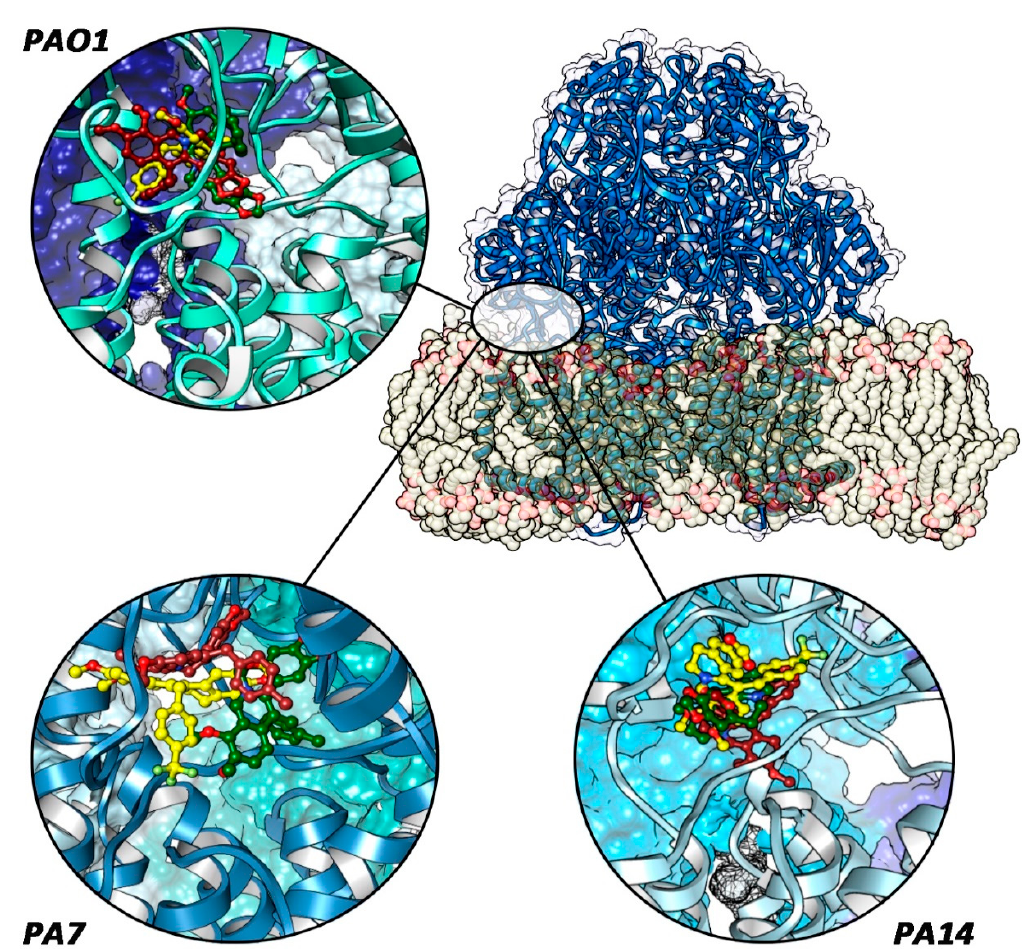
Figure 4. Final ligand poses (p-CF 3 , blue-colored; o-CH 3 , yellow-colored; and p-CH 3 , green-colored) in each protein system. The red circle indicates the periplasmic site between TM7 and TM8 helices. Only in PA7–MexY complexes are the compounds fully located inside it. Table 4. Tobramycin (TOB) MIC in the absence/presence of berberine 80 µ g/mL (Be)